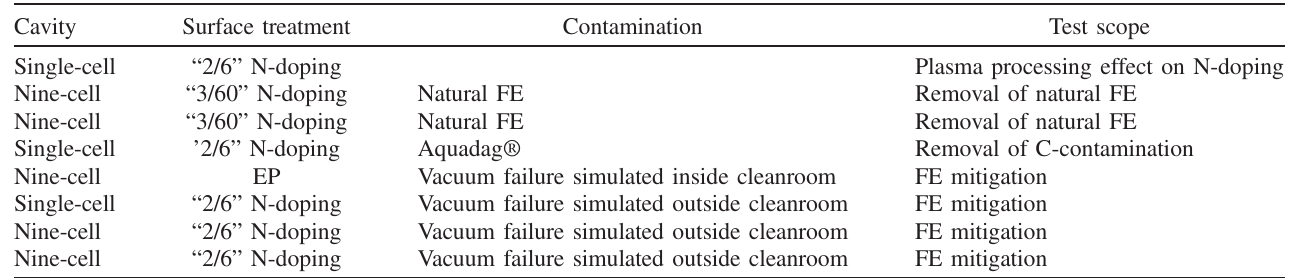
TABLE II. Summary of the 1.3 GHz single-cell and nine-cell TESLA-shaped cavities cold tested for plasma processing studies. The terminology “ n/m ” for the nitrogen doping is to be interpreted as n minutes in 25 mTorr of nitrogen and m minutes of annealing in